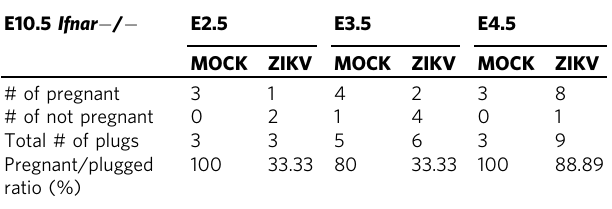
Table 1 The pregnancy rate of infected Ifnar − / − mice in